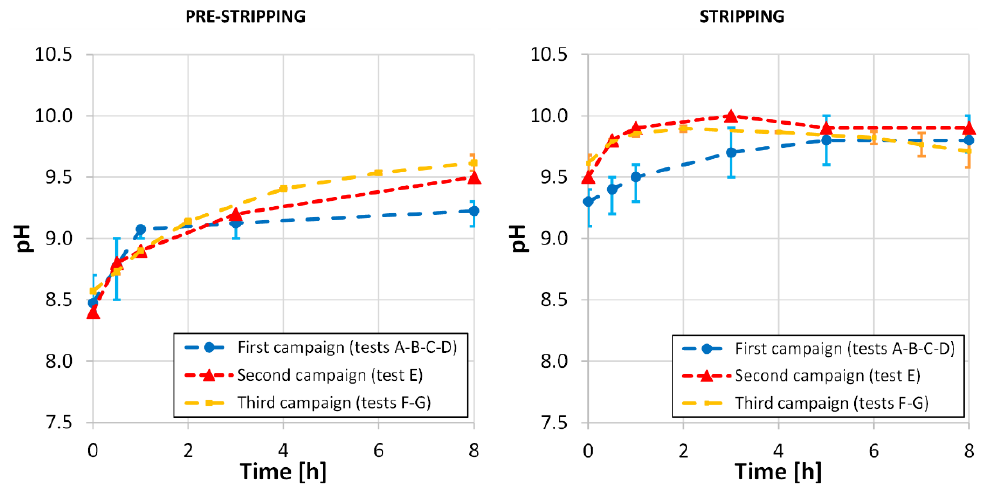
Figure 3. Trend of pH during the pre-stripping and stripping phases for the three campaigns. Baffles show the variation among tests of the same campaign.